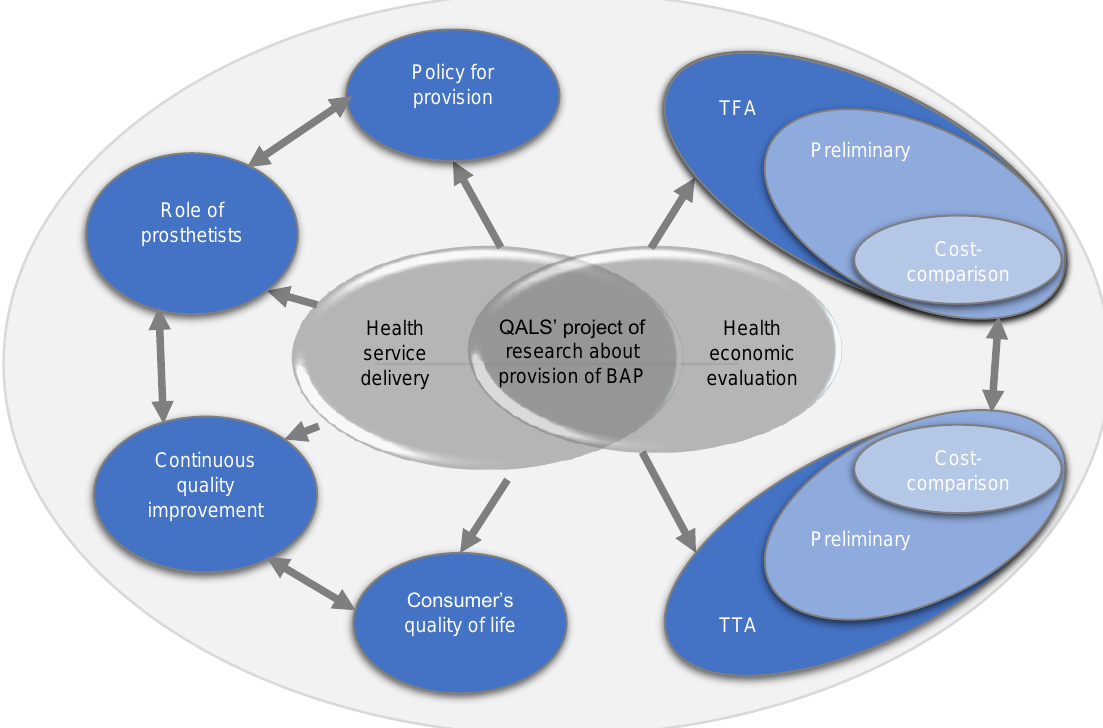
Figure 1: Overview of the research project focusing health service delivery and health economic evaluations of transfemoral (TFA) and transtibial (TTA) bone-anchored prostheses (BAPs) led by the Queensland Artificial Limb Service